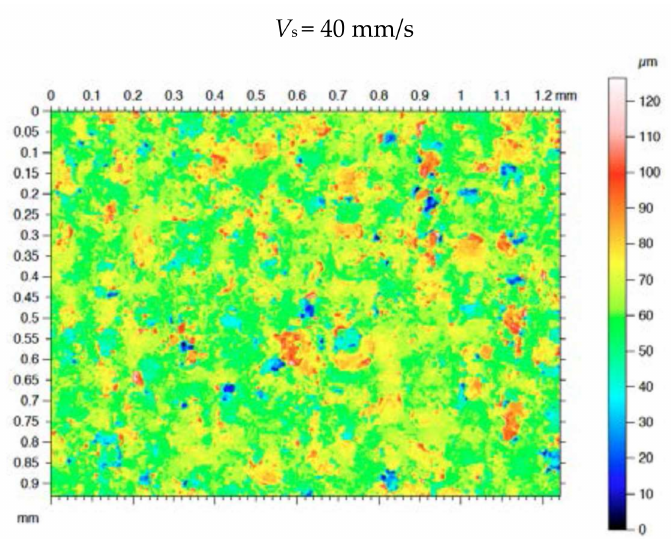
Figure 9. Topographic evolution of the textured layer for the S -I speed set, which has lower scanning speeds ( V s = 10 mm/s to V s = 40 mm/s).